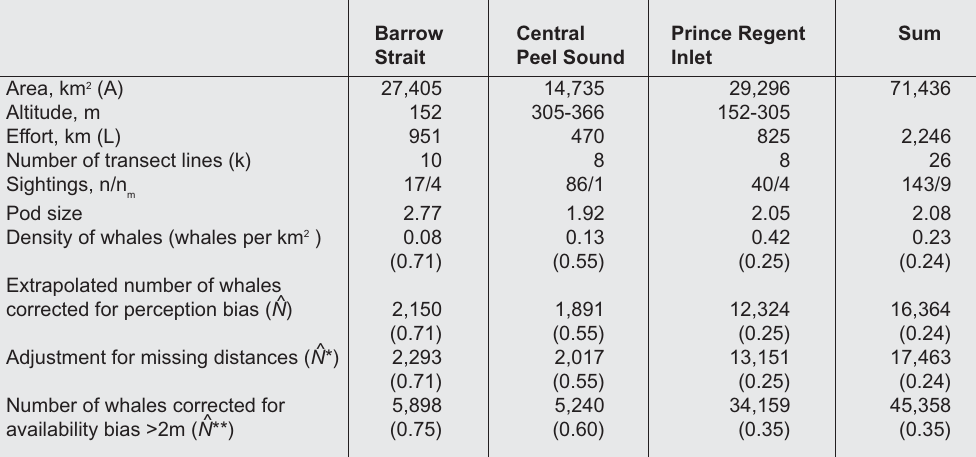
). The corrected num- m